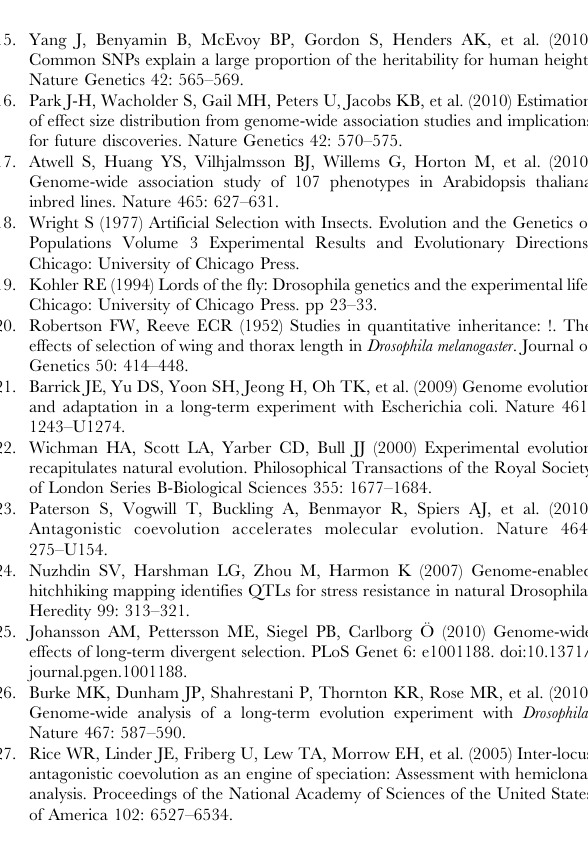
and had stored sperm. Figure S2 Differentiation of all chromosomes. The diffStat is shown for each variant that had higher or lower allele frequencies in the large-selected lines compared to the small-selected lines. Color coding indicates significance: black= nonsignificant vari- ants, blue = significant variants at the permissive FDR threshold (FDR , 10%); gold= significant variants at the restrictive FDR threshold (FDR , 5%); red= peak variants. Left arms (L) are the to left of the centromere (centromere is after high x-axis values), and the right (R) arms are to the right of the centromere (centromere is before low x-axis values). Figure S3 Differentiation of all chromosomes. The diffStat is shown for each variant that had higher or lower allele frequencies in the large-selected lines compared to the small-selected lines. Color coding indicates estimated starting allele frequency: black = all variants, gold =variants with an average control frequency , 0.05; red= peak variants. Left arms (L) are the to left of the centromere (centromere is after high x-axis values), and the right (R) arms are to the right of the centromere (centromere is before low x-axis values). Figure S4 Examples of significantly differentiated genes. The diffStat is shown for each variant at each locus; colors are as in figure S2. A: At EGFR several polymoprhisms are significantly differentiated across 25-kb, B: At dally, a large region of